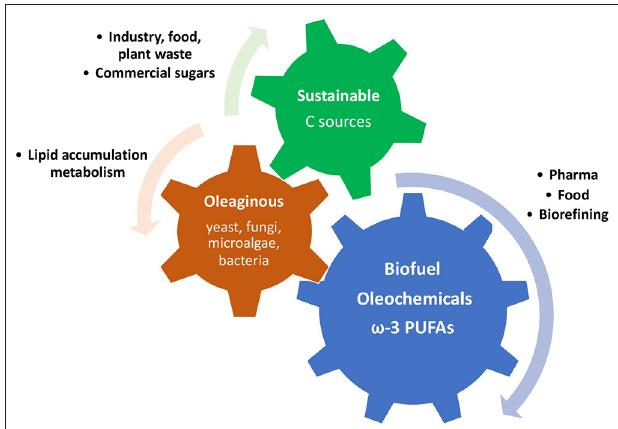
FIGURE 5 | Schematic representation of the mechanism of production and utilisation of fatty acids and lipids produced by oleaginous microorganism using cost-effective carbon